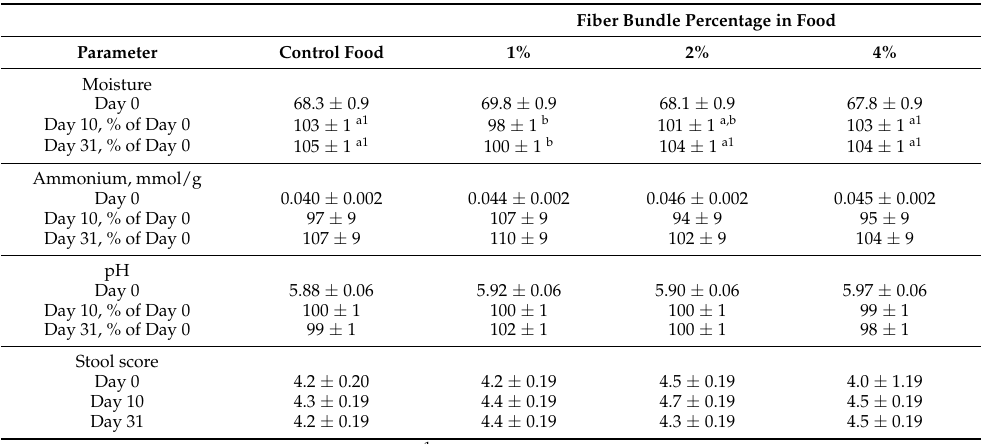
Table 3. Fecal moisture, ammonium, and pH at baseline, end of study, and change from baseline (Day 0) and stool scores in dogs that consumed foods containing 0%, 1%, 2%, or 4% of added fiber-bound polyphenol ingredients.